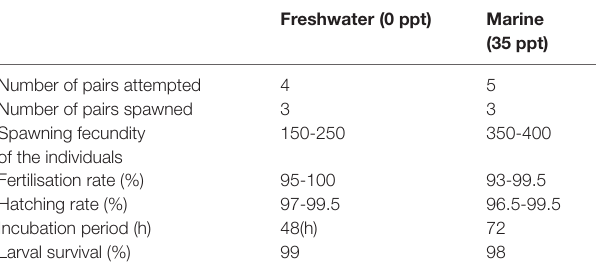
TABLE 7 | Breeding performance of Orange chromide reared in different